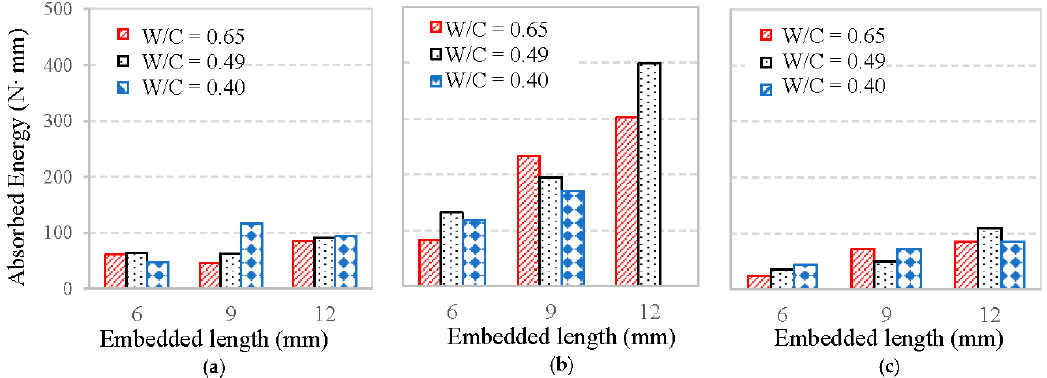
Figure 12. Energy absorption: ( a ) basalt fiber, ( b ) PVA fiber, and ( c ) glass fiber.